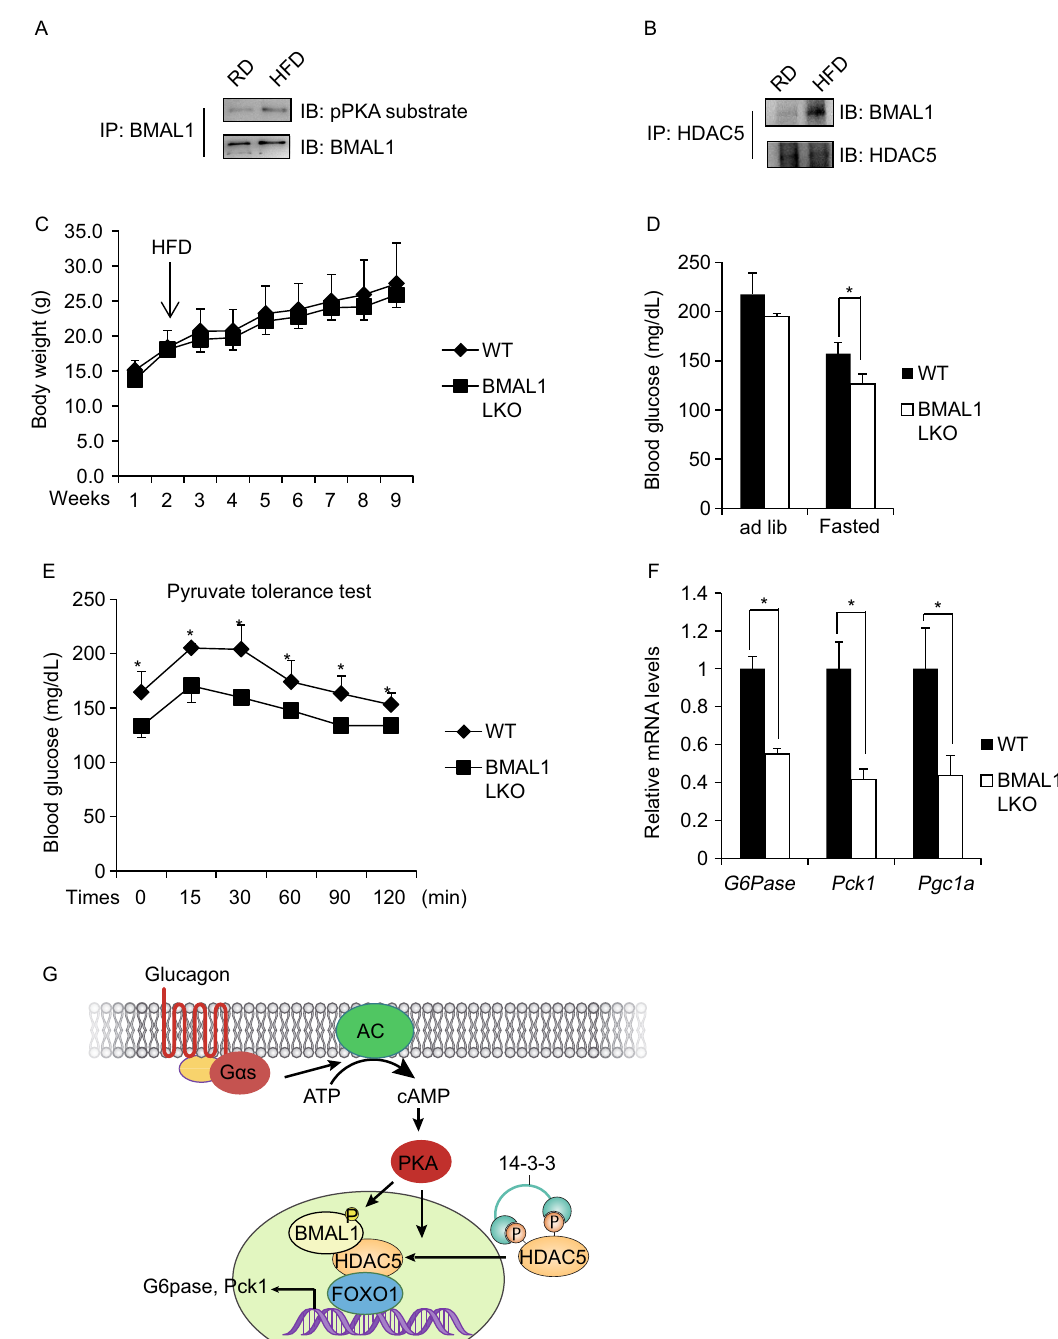
Figure 2. De fi ciency of hepatic BMAL1 attenuates hyperglycemia in HFD-fed mice . (A) Immunoblot showing phosphorylation levels of BMAL1 in RD- or HFD-fed mice. (B) Immunoblot of BMAL1 recovered from immunoprecipitations of HDAC5 from liver samples in RD- or HFD-fed mice. (C) Weight gain in BMAL1 LKO and control littermates fed on HFD ( n = 6). (D) Blood glucose levels under ad lib and fasted conditions in BMAL1 LKO and control littermates maintained on HFD ( n = 6). (E) Pyruvate tolerance test of BMAL1 LKO and control littermates maintained on HFD ( n = 6). (F) Effect of fasting on mRNA amounts for hepatic gluconeogenic genes in liver of BMAL1 LKO and control littermates maintained on HFD ( n = 6). (G) Schematic of proposed mechanism. All data are presented as mean ± s.e.m. * P <